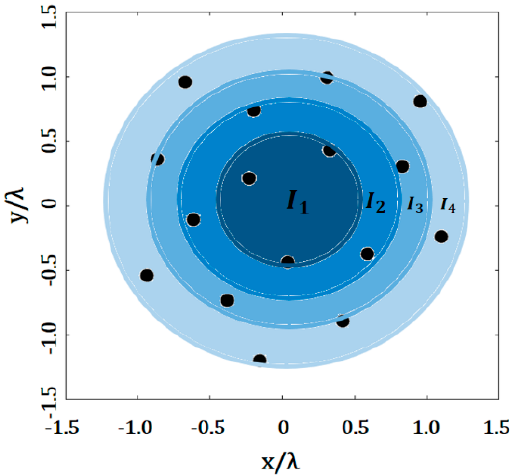
Figure 2. Application of the raised cosine distribution to the Fermat spiral.